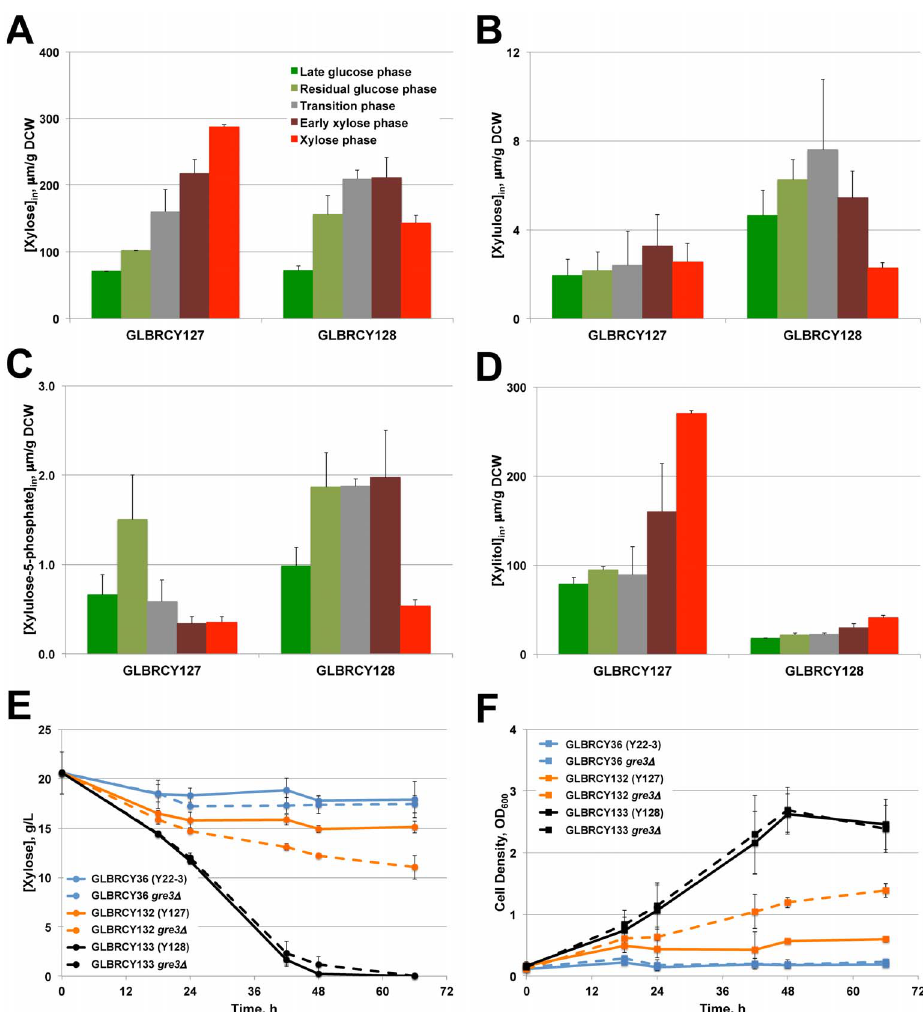
Figure 7. Y128 has a mutation in GRE3 that reduces xylitol production and contributes towards anaerobic xylose fermentation. Fermentation samples were taken at the indicated time points marked by vertical colored bars in Fig. 5B and C. Cells were then filter-captured, briefly washed and then intracellular metabolites extracted. Average concentrations of xylose ( A ), xylulose ( B ), xylulose-5-phosphate ( C ) and xylitol ( D ) from independent duplicate fermentations were determined by reverse phase ion pairing HPLC-ESI coupled with MS/MS or gas chromatography (see Materials and Methods). Average concentrations and standard deviations are based on two biological replicates. Y22-3, Y127 and Y128 strains with KanMX selection markers excised (Y36, Y132 and Y133, respectively) and with or without deletion of GRE3 were cultured under anaerobic conditions in YPX media. Samples were taken at the indicated time points to measure xylose concentrations ( E ) or cell density ( F ). Average values and standard deviations were calculated from biological